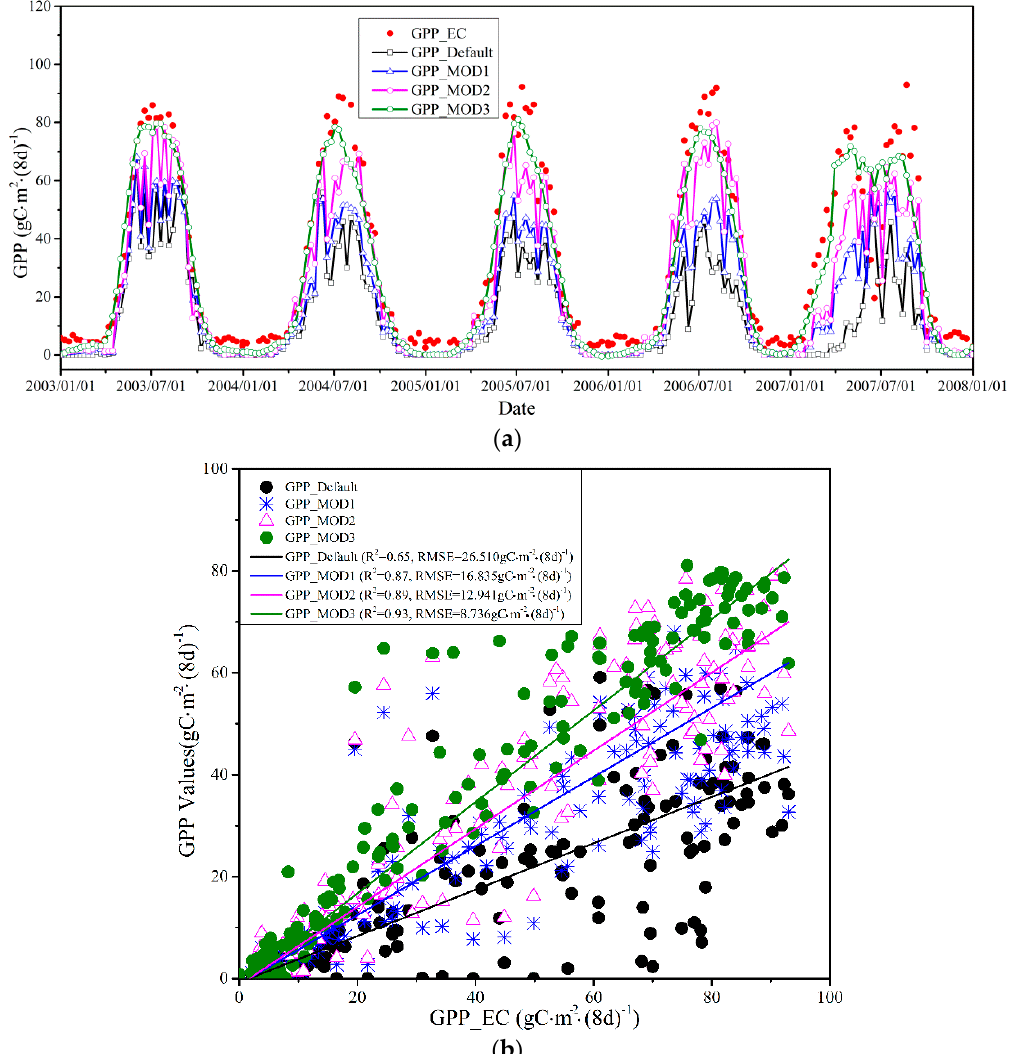
Figure 2. Seasonal performances ( a ) and comparisons ( b ) of eight-day GPPs obtained from the original products (GPP_Default), three simulations (GPP_MOD1, GPP_MOD2, and GPP_MOD3), and EC measurements (GPP_EC) at Changbai Mountains forest flux site between 2003 and 2007.